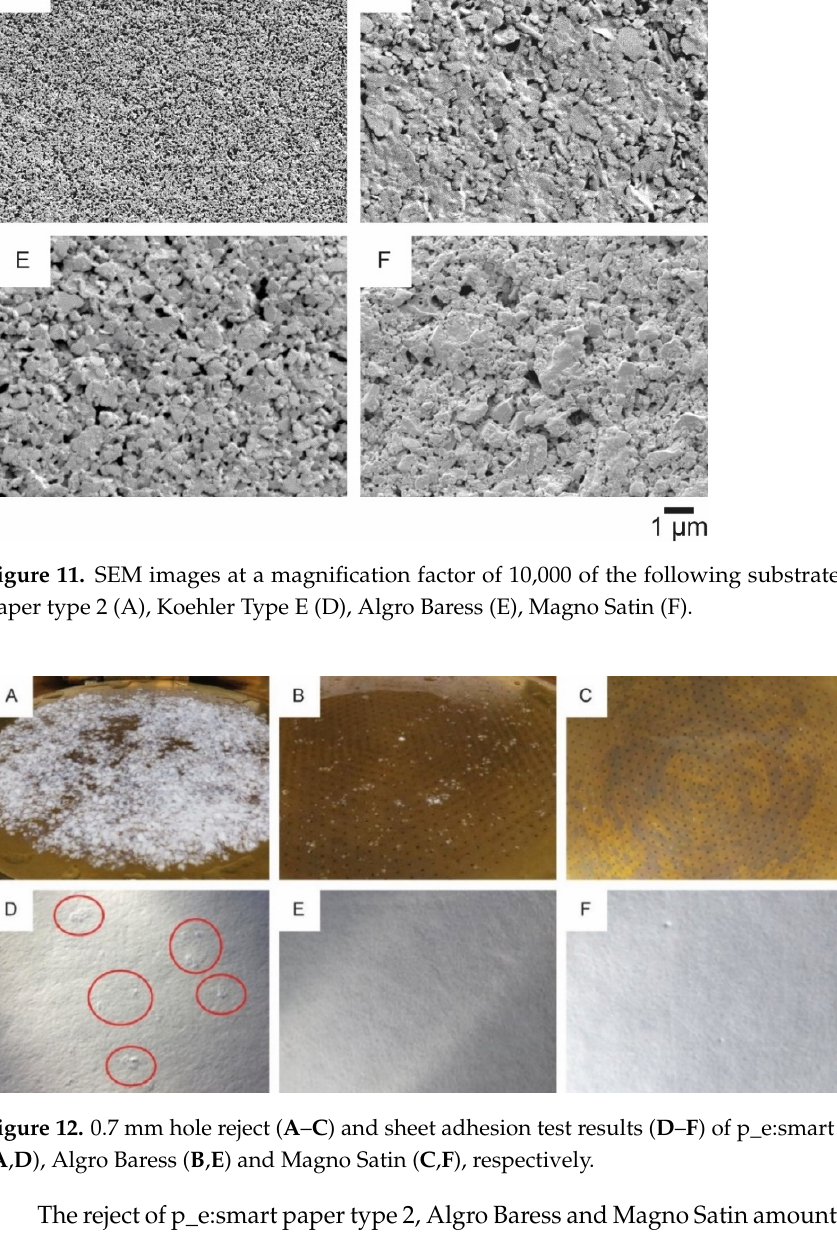
Figure 12. 0.7 mm hole reject ( A – C ) and sheet adhesion test results ( D – F ) of p_e:smart paper type 2 ( A , D ), Algro Baress ( B , E ) and Magno Satin ( C , F ), respectively. The reject of p_e:smart paper type 2, Algro Baress and Magno Satin amounted 56.0 m%, 0.7 m% and 0.8 m%, respectively. The reject of p_e:smart paper type 2 consisted of